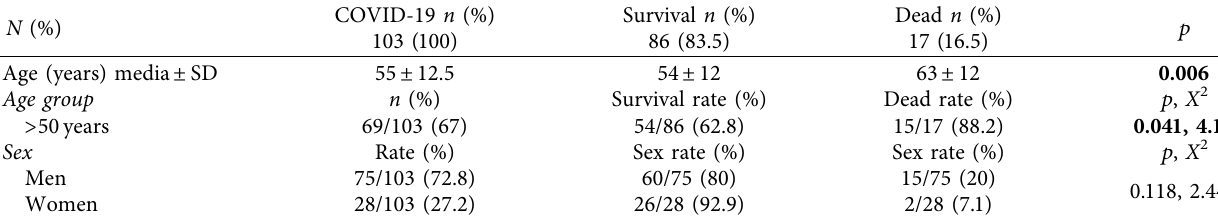
Table 1: Demographics of